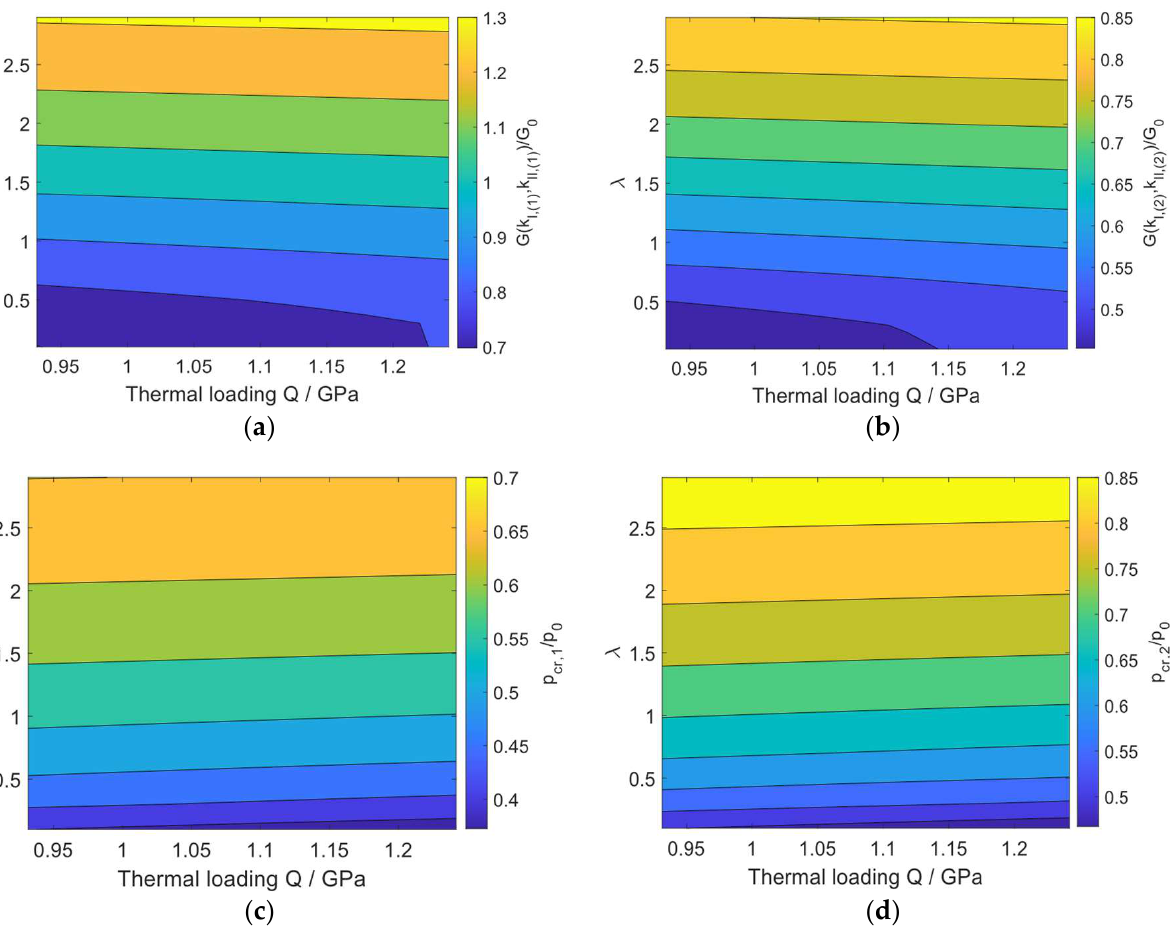
Figure 4. Influence of thermal loading Q and gradation parameter λ on ERR ( a , b ) and critical load ( c , d ); ( a , c ) for crack 1 and ( b , d ) for middle crack 2.